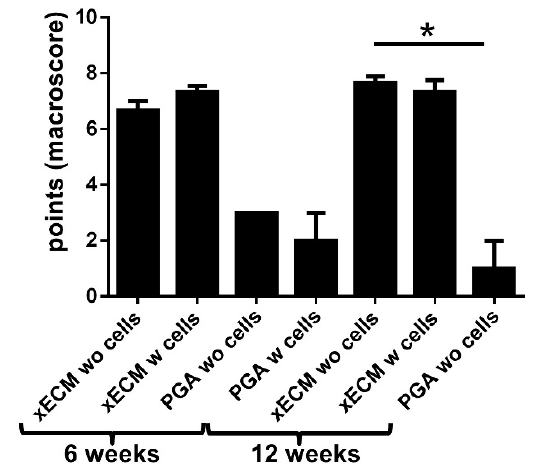
Figure 2. Macroscopical appearance of native porcine AS tendon and decellularized xECM or PGA seeded or not with human tenocytes after six and 12 weeks in vivo. ( A 1 ) native tendon, ( A 2 ) PGA after seven days in vitro. ( B 1 , D 1 ) cell-free xECM, ( C 1 , E 1 ) recellularized xECM. ( B 1,2 – C 1,2 ) Explanted from nude mice after six weeks. ( D 1,2 – E 1,2 ) Explanted from nude mice after 12 weeks.